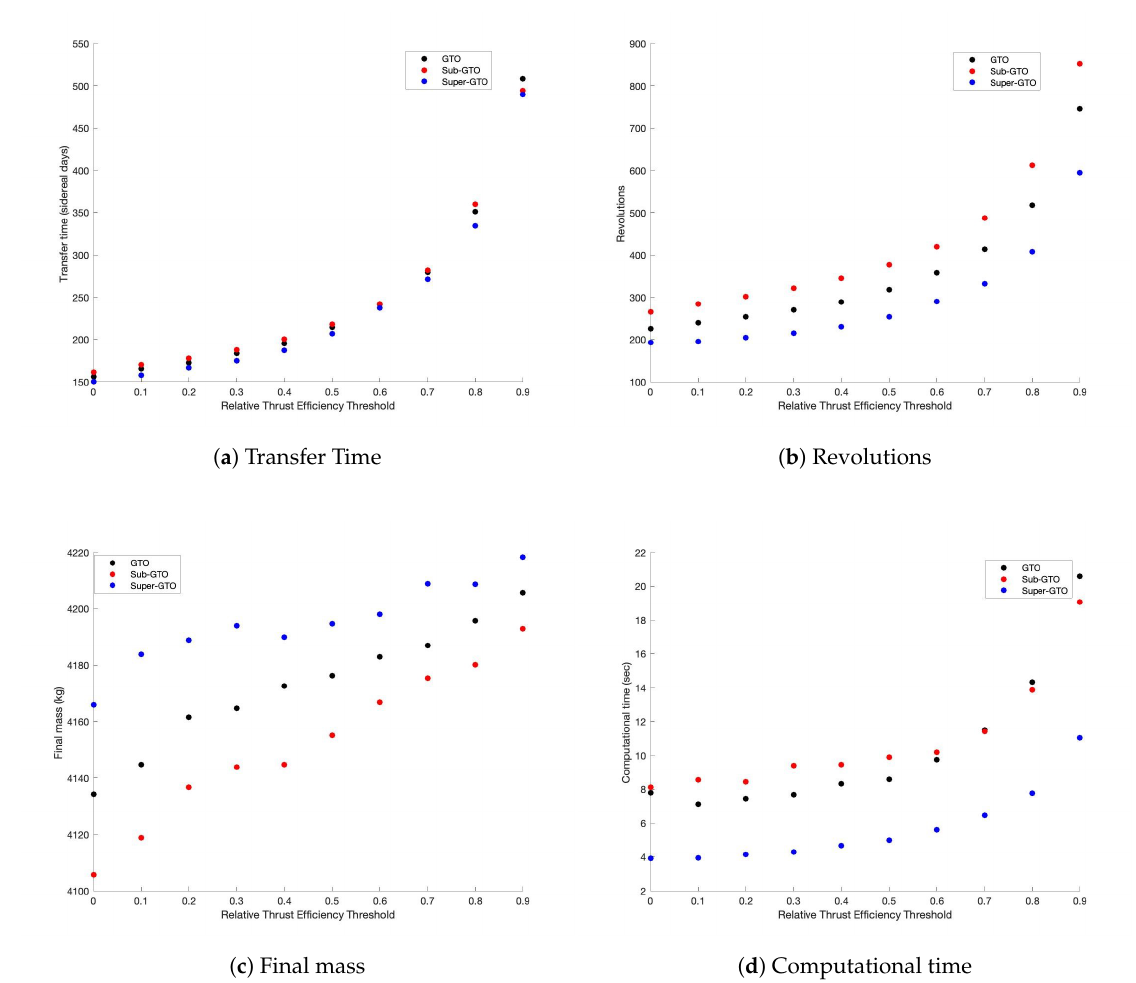
Figure 14. Performance parameters with coasting ON with respect to the thrust efficiency